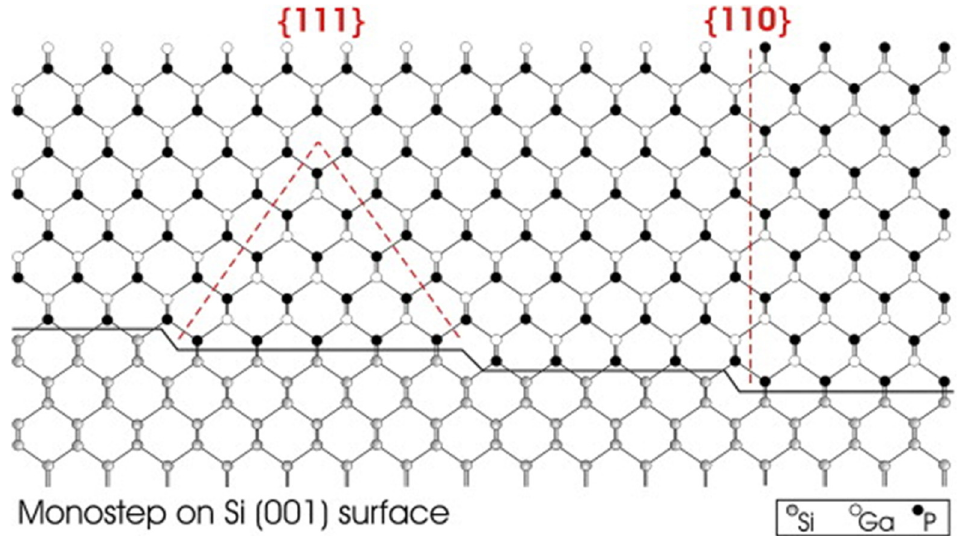
Figure 1. Schematic representation of the formation of antiphase boundaries (APBs) in GaP on silicon (Si) due to the presence of monatomic steps on the (001) Si surface. Reprinted with permission from Reference [75] © 2008 Elsevier B.V.